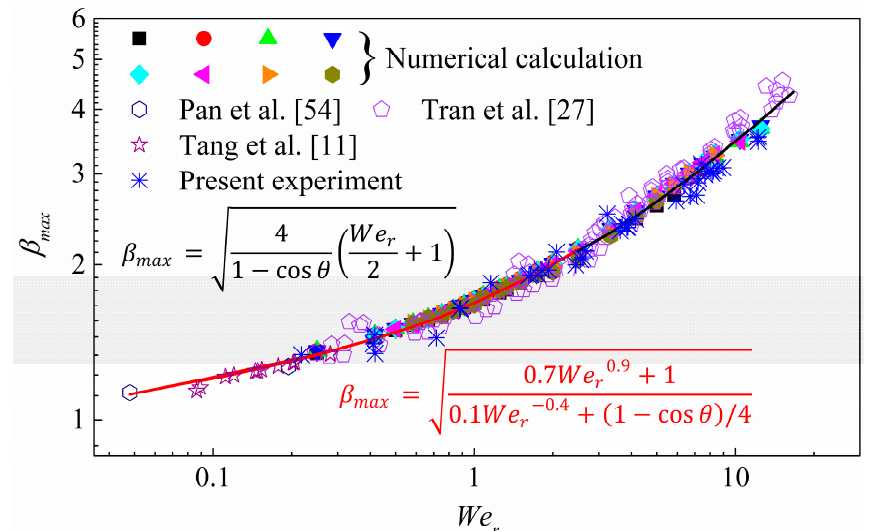
Figure 15. Comparison between the derived spreading models (black solid line indicates Wildeman et al.’s model [40], while the red line denotes the present proposed model) and data points (Tang et al.’s experimental results (denoted by the pentagram symbols) [11], Tran et al.’s experimental results (denoted by the pentagon symbols) [27], Pan et al.’s experimental results (denoted by the hexagon symbols) [54], present experiment and numerical predictions).